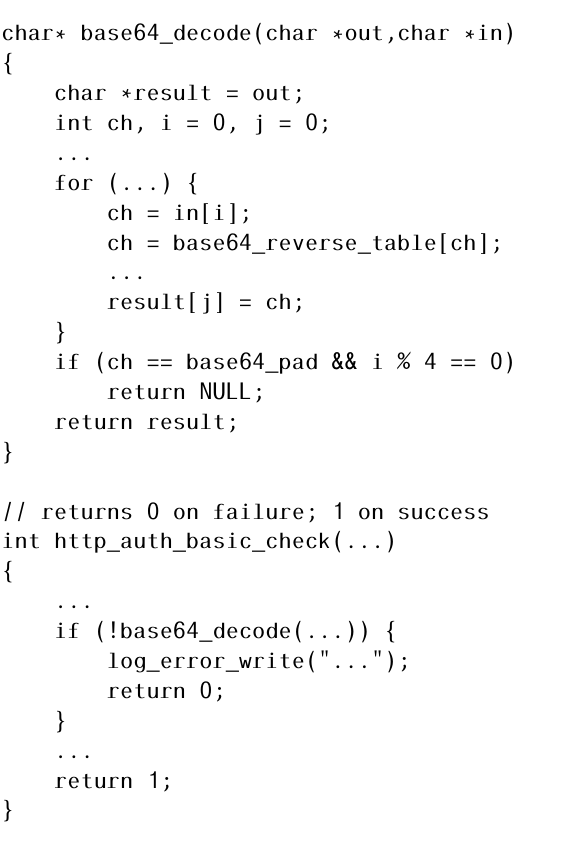
Figure 1. Example vulnerability, adopted from CVE-2011-4362 in lighttpd .